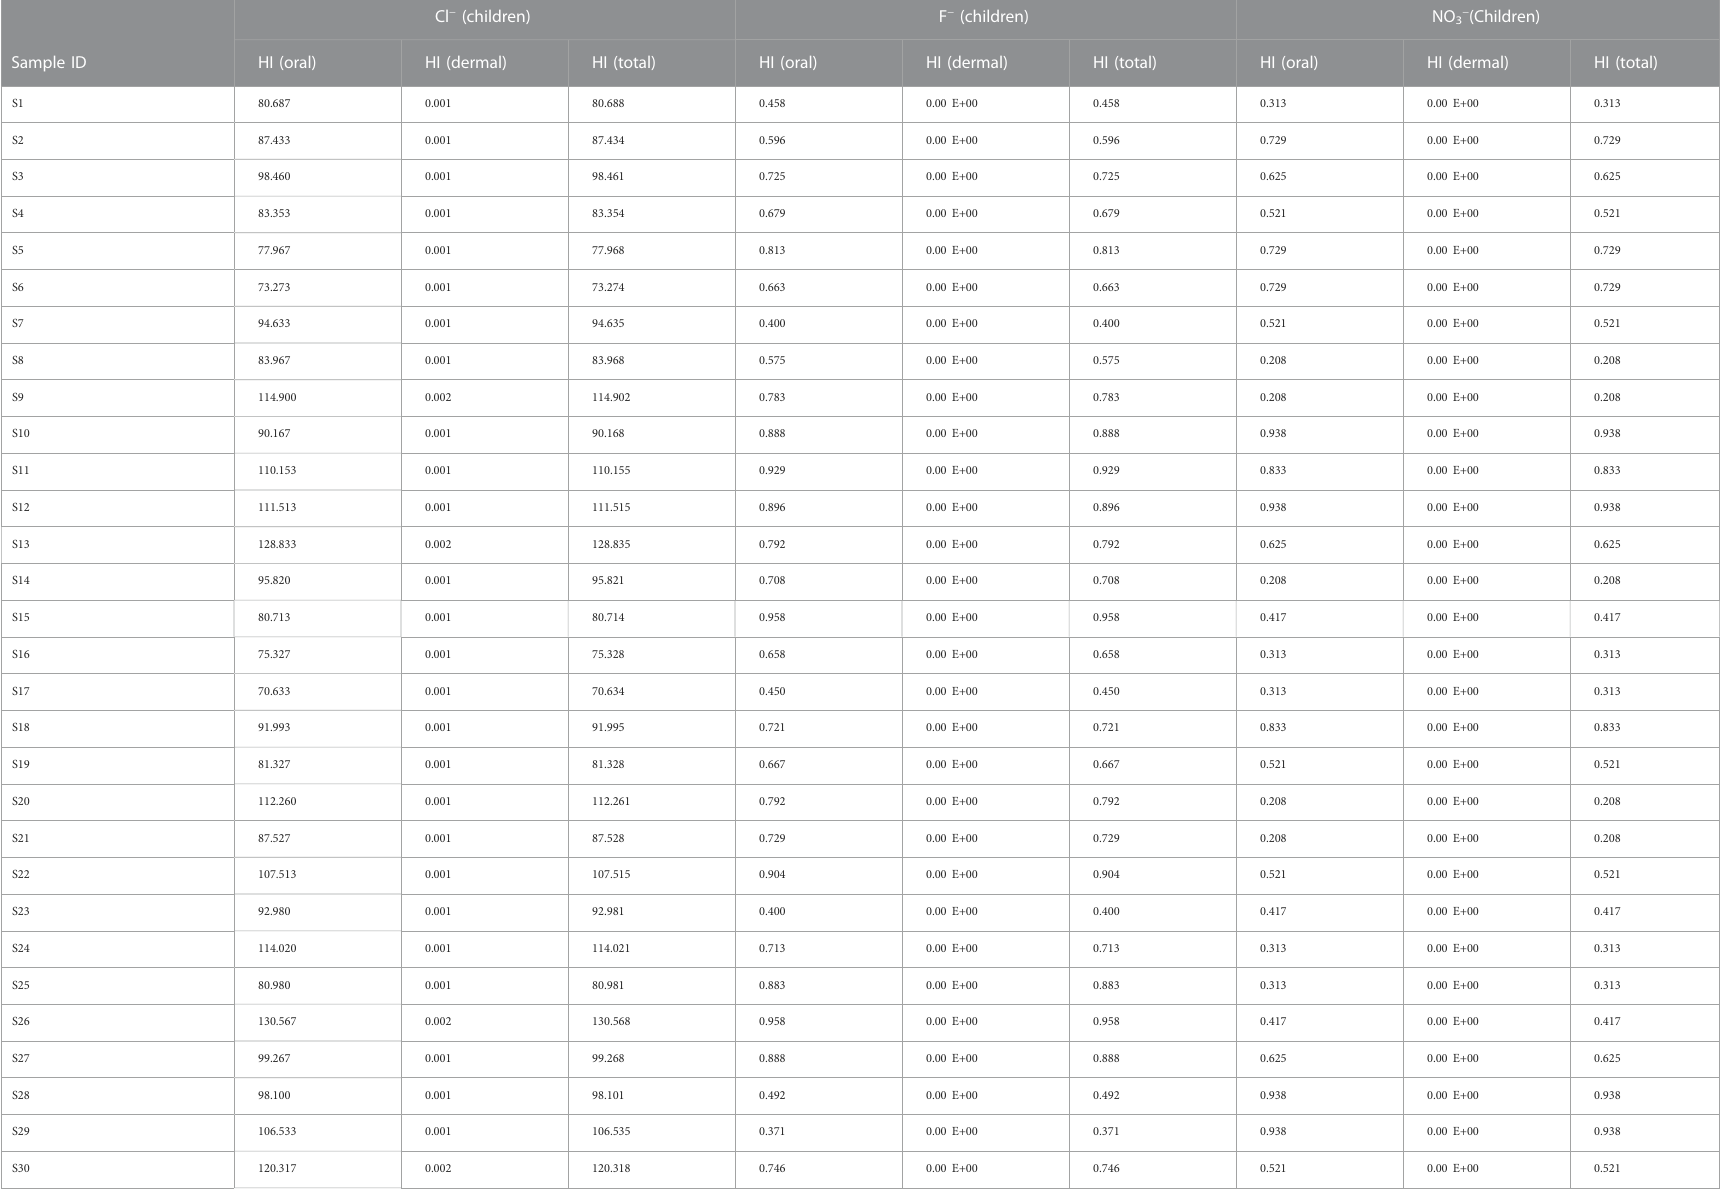
TABLE 8 Results of Chloride, fl uoride and Nitrate health risk assessment for children